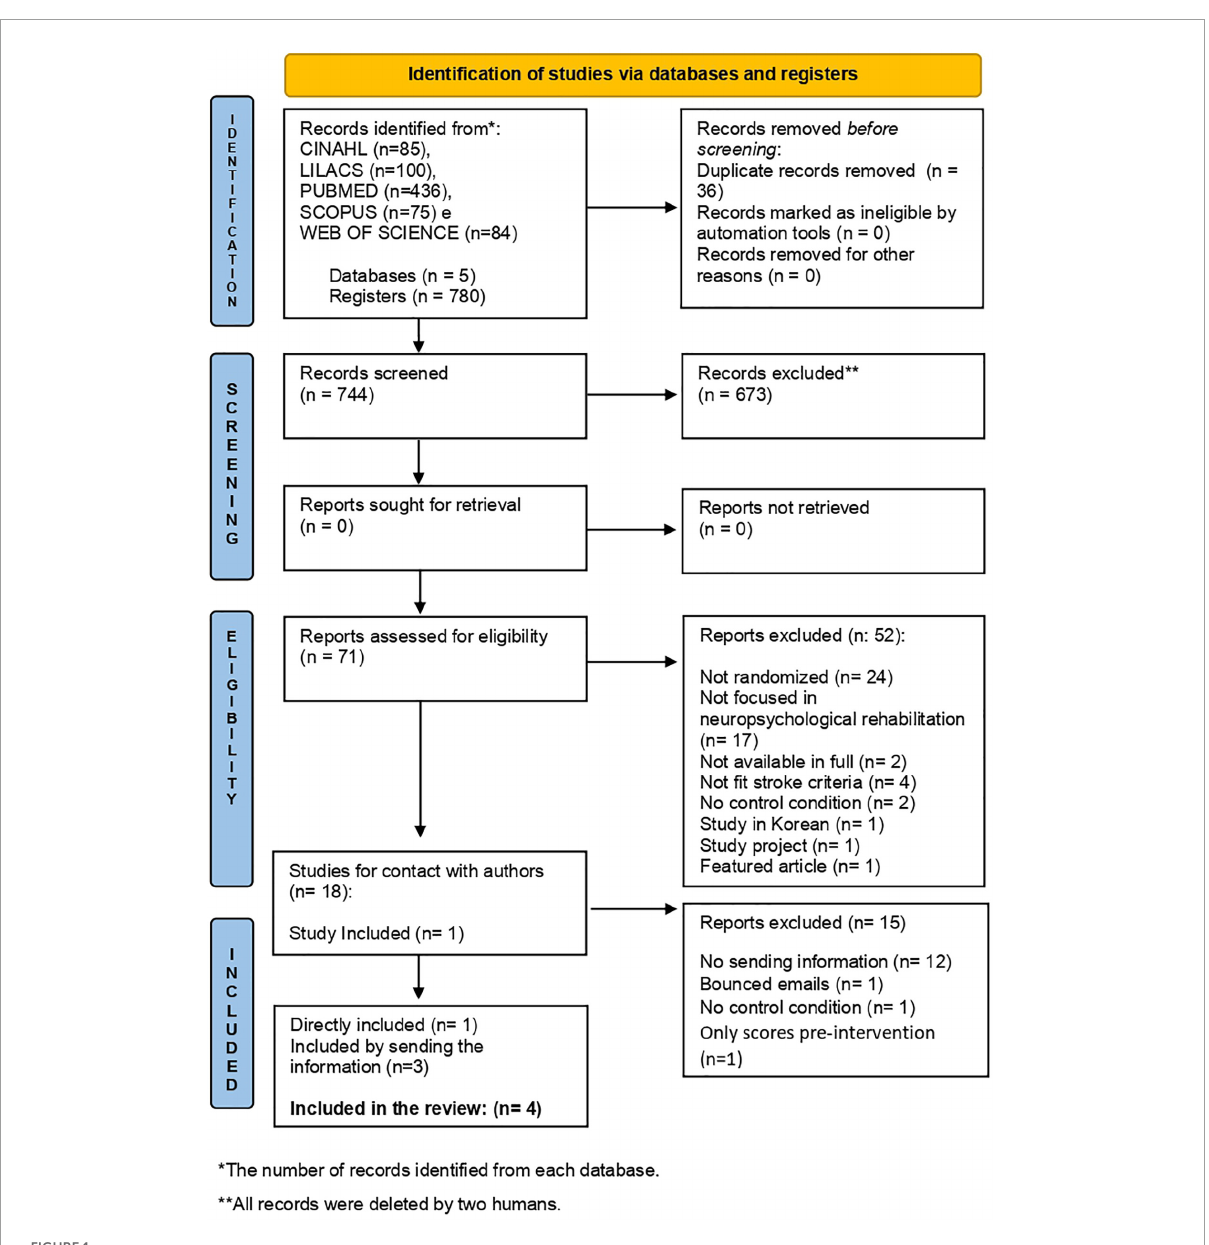
FIGURE1 Flow diagram: research and selection process according to PRISMA